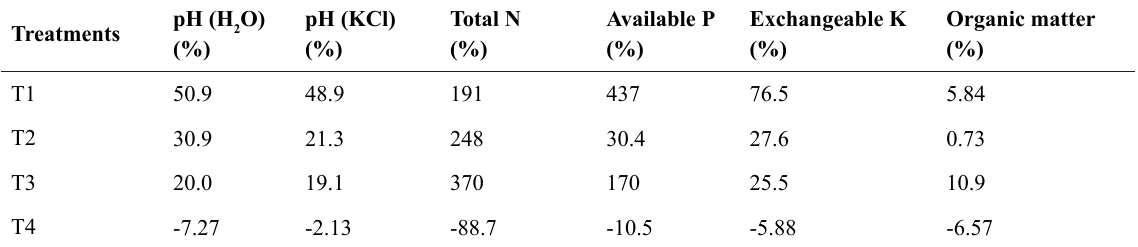
Table 3 Percentage changes in soil chemical properties after crop harvest relative to initial soil characteristics Treatments